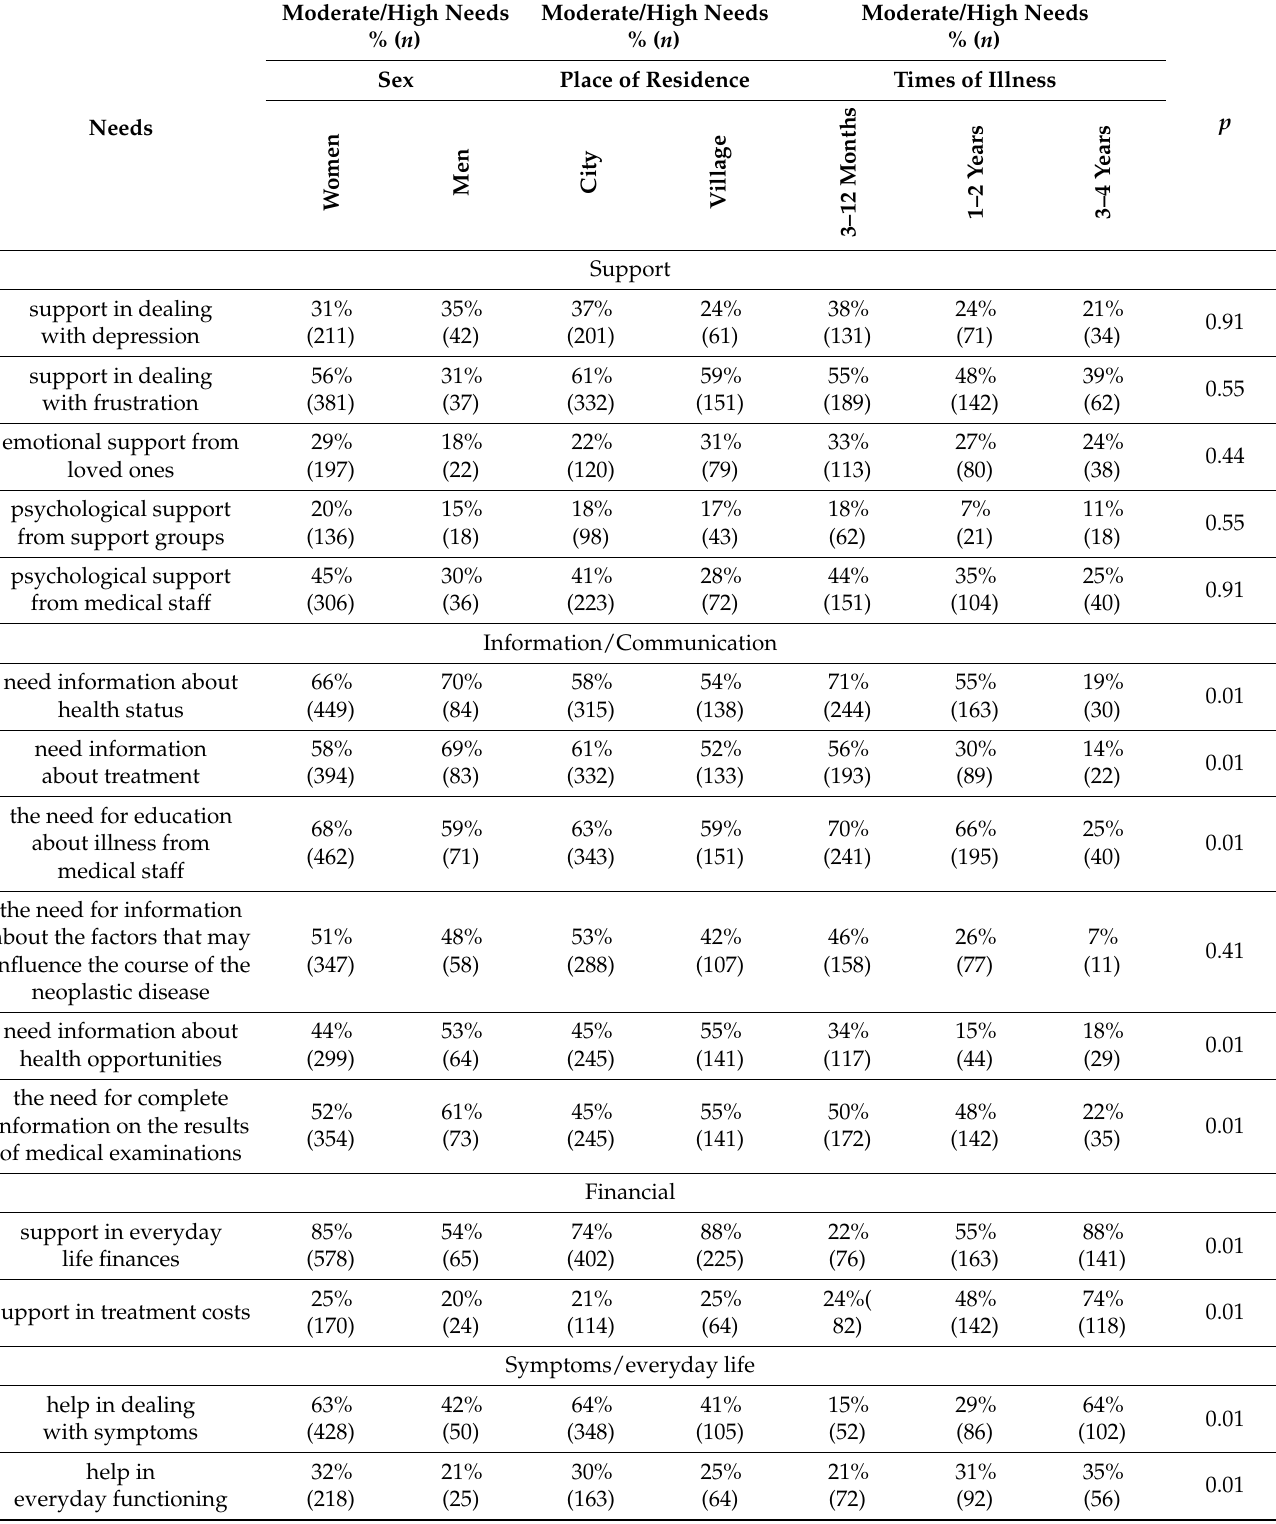
Table 2. Moderate and high parents’